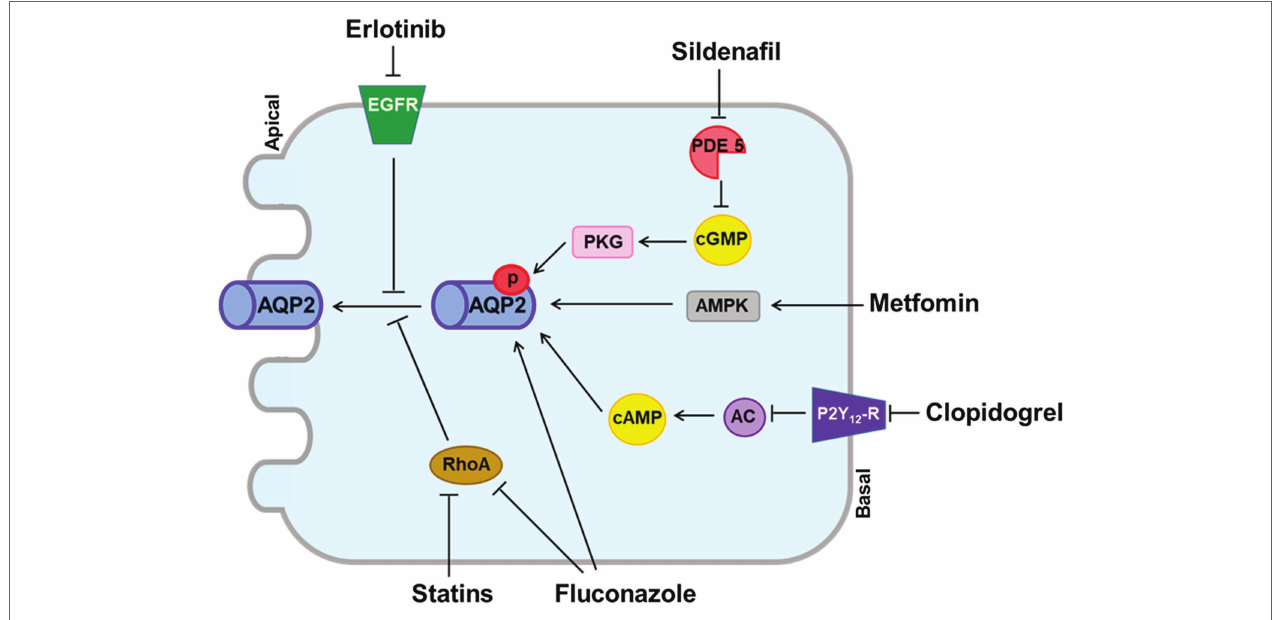
FIGURE 2 | Vasopressin V2 receptor (V2R)-independent pathways for aquaporin-2 (AQP2) upregulation induced by experimental antidiuretic agents. The phosphodiesterase-5 inhibitor sildenafil citrate prevents degradation of cGMP, resulting in increased AQP2 expression in the apical membrane. Erlotinib inhibits the tyrosine kinase activity of epidermal growth factor receptor (EGFR) and increases phosphorylation of AQP2 at Ser-256 and Ser-269. Metformin activates adenosine- monophosphate-activated protein kinase (AMPK) to phosphorylate AQP2. Clopidogrel inhibits the P2Y 12 receptor (P2Y 12 -R) and increases adenylyl cyclase activity, resulting in AQP2 upregulation. Fluconazole upregulates AQP2 by increasing phosphorylation and abundance and by inhibiting RhoA. Statins inhibit RhoA, resulting in increased AQP2 expression in the apical